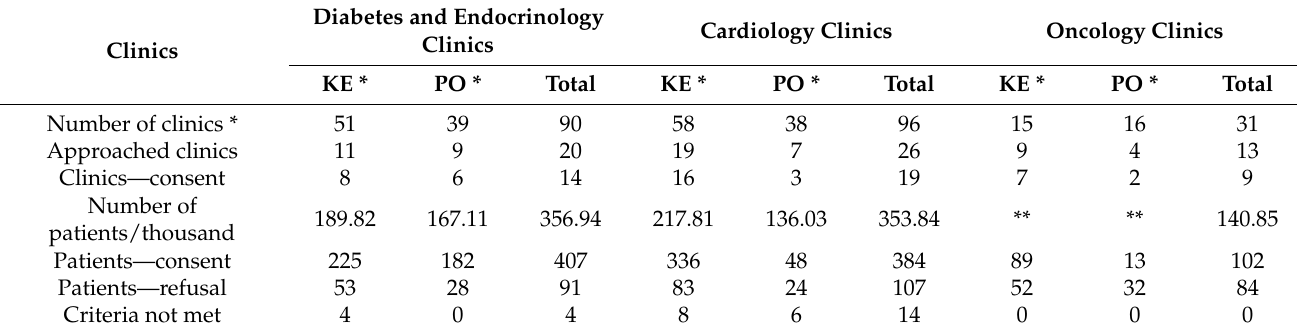
Table 2 specifies the survey sampling method: the number of outpatient clinics in both regions of eastern Slovakia in the observed year, the total number of clinics contacted, and clinics that gave written consent. It also presents the number of patients treated for the diseases we monitored, the number of patients who gave written consent, and the number of patients who refused to participate in our survey and of those excluded owing to not meeting the above criteria. Table 2. Survey sampling